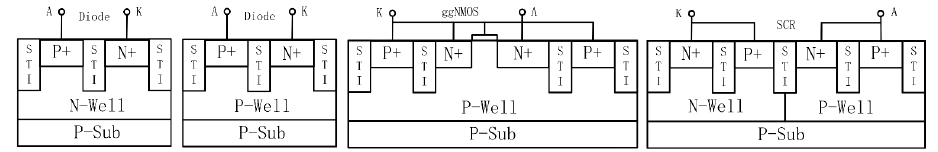
Figure 3. Traditional in-Si PN-based ESD protection structures (A = anode and K = cathode).